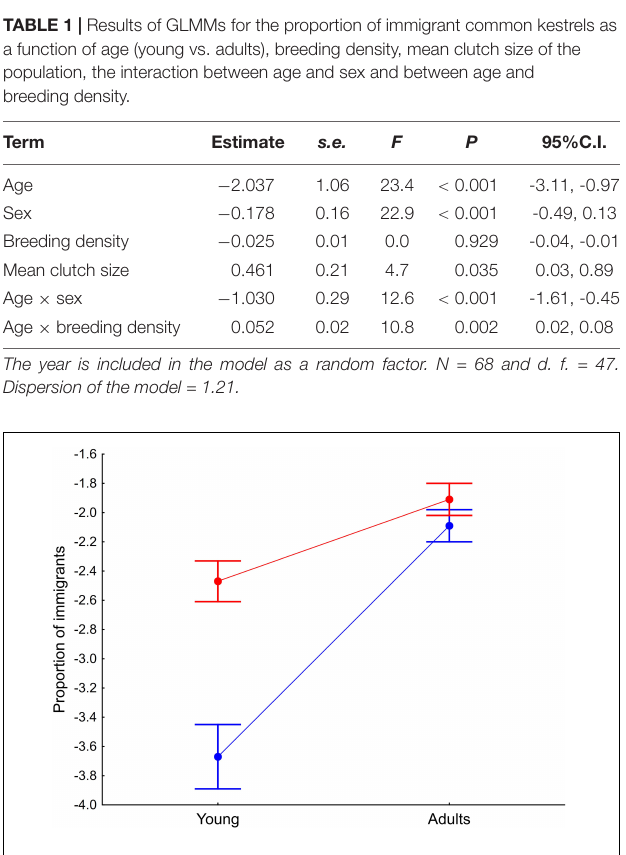
FIGURE 1 | Interaction between sex and age in the proportion of common kestrel immigrants (residuals from the GLMM). Red and blue colors represent females and males, respectively. Dots and whiskers represent mean and s.e. values, respectively.